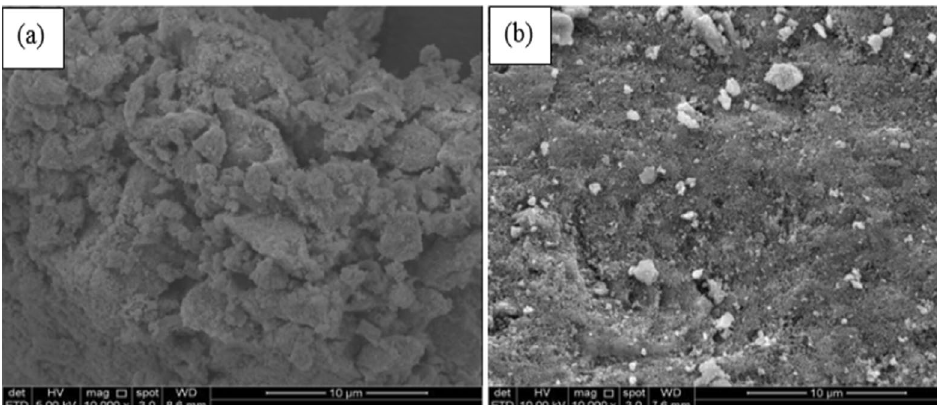
Fig. 2 SEM micrographs of (a) bare Fe 3 O 4 and (b) Fe 3 O 4 @MAA-βCD